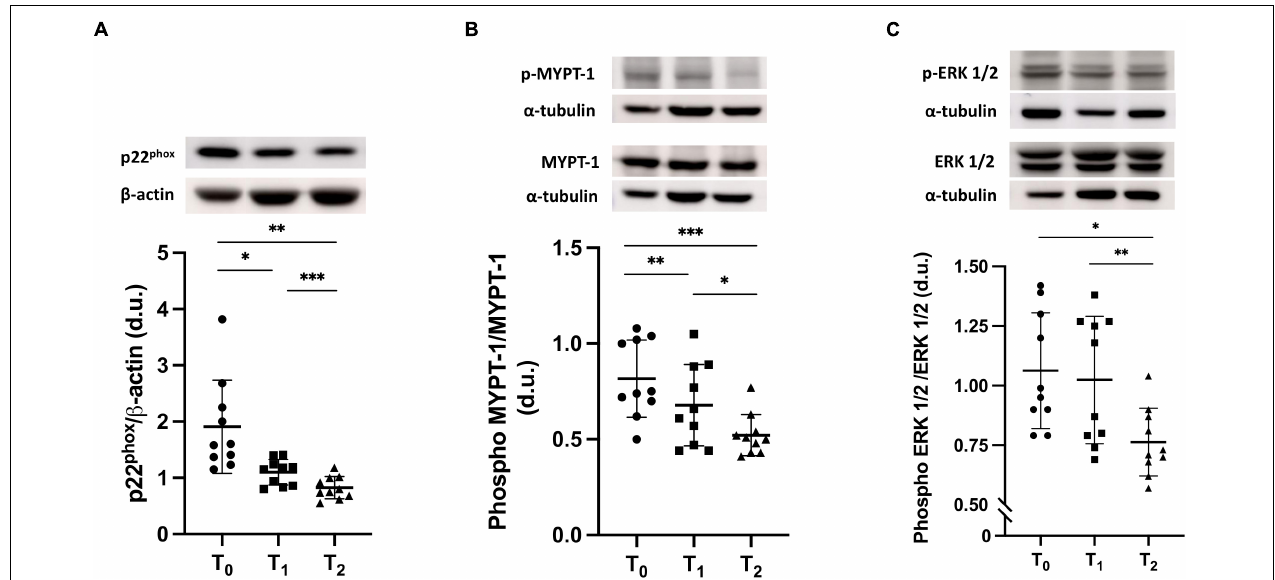
FIGURE 2 | (A) p22 phox protein expression in FD patients before ERT (T 0 ), after 12 months of ERT treatment (T 1 ) and after 6 months of treatment with green tea on top of ERT (T 2 ). The top part of the panel shows representative Western blot products of p22 phox protein expression of one patient. T 0 vs. T 1 , * p = 0.01; T 0 vs. T 2 , ** p = 0.001; T 1 vs. T 2 , *** p < 0.001. Repeated measures for one-way ANOVA, p = 0.003. (B) MYPT-1 phosphorylation state in FD patients at baseline (T 0 ), at T 1 and at T 2 . The top part of the panel shows representative Western blot products of p22 phox protein expression of one patient. T 0 vs. T 1 ** p < 0.001; T 0 vs. T 2 *** p < 0.0001; T 1 vs. T 2 , * p = 0.003. Repeated measures for one-way ANOVA, p < 0.001. (C) Phosphorylation state of ERK 1/2 in FD patients at T 0 , at T 1 and at T 2 . The top part of the panel shows representative Western blot products of p22 phox protein expression of one patient. T 0 vs. T 1 p = ns ; T 0 vs. T 2 * p = 0.003; T 1 vs. T 2 , ** p = 0.002. Repeated measures for one-way ANOVA, p = 0.002.